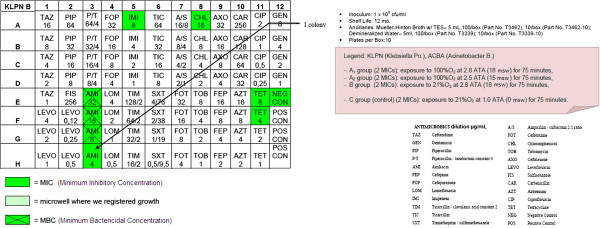
KLPN plate exposed to 21% O2at 2.8 ATA.